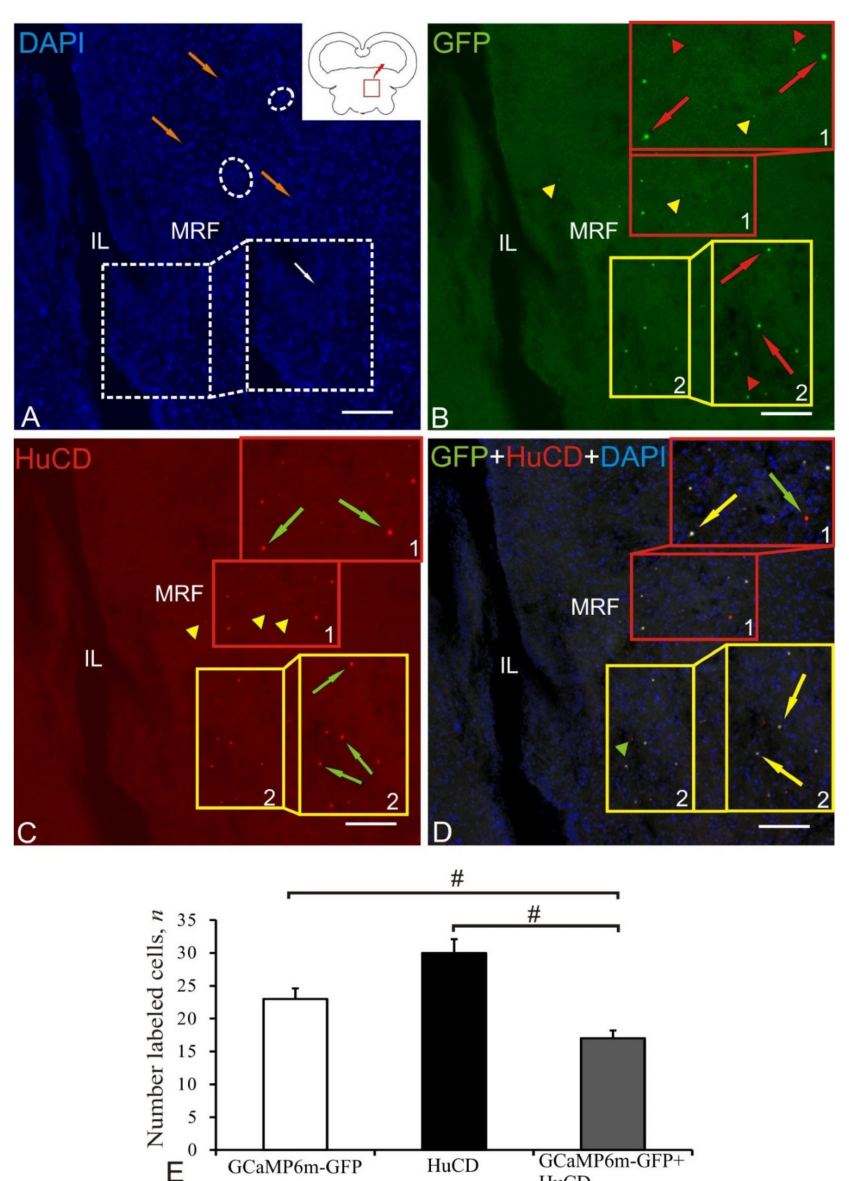
Figure 8. Z-stacks representing HuCD immunolabeling in the mesencephalic reticular formation of juvenile chum salmon, O. keta , at 1 week after a single injection of recombinant AAV into the mesencephalic tegmentum. ( A ) DAPI staining, a diagram of the AAV injection area (indicated by red zigzag) and the distribution of GFP expressing cells in the MRF is shown in the pictogram (outlined by the red square), labeled cell nuclei (orange arrows) and their clusters (outlined by the white oval), along the injection lumen (IL), invaginations of the parenchymal brain tissue were revealed, with heterogeneous clusters of stained nuclei (outlined by the white dotted rectangle), forming reactive neurogenic zones (dotted inset). ( B ) GFP expression in population № 1 (outlined by the red rectangle) containing GFP+ neurons (shown in the inset, red arrows), GFP+ nuclei (red arrowheads) and GFP+ granules (yellow arrowheads) and population № 2 (yellow rectangle, inset). ( C ) HuCD immunofluorescence in populations № 1 and 2, neurons are indicated by green arrows in the inset, yellow arrowheads indicate granules. ( D ) Superposition of three channels of DAPI/GFP/HuCD staining in population № 1 of neurons (yellow arrow) and GFP-/HuCD+ cells (green arrow), in population № 2 (inset in yellow rectangle), GFP–/HuCD+ granules (green arrowheads). ( E ) Results of ANOVA analysis showing the comparative distribution of labeled cells and nuclei (M ± SD, where M is the mean and SD is the standard deviation) in the MRF of juvenile chum salmon. Significant intergroup differences (# < 0.05) were found between the groups of GCaMP6m-GFP+ and GCaMP6m-GFP+/HuCD+ cells and the groups of HuCD+ and GCaMP6m-GFP+/HuCD+ cells ( n = 5 in each